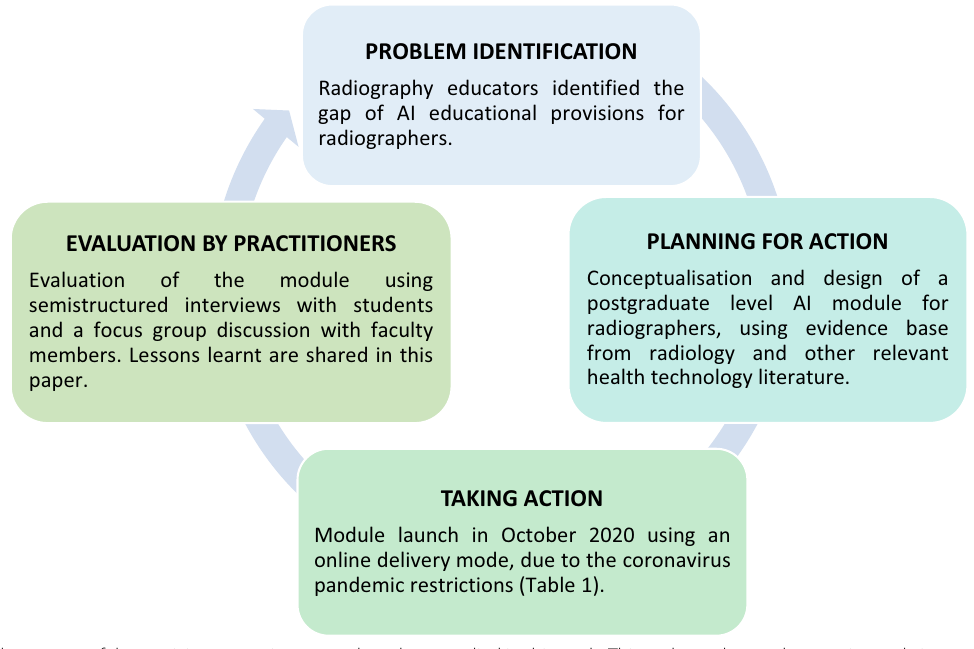
Fig. 1 Visual summary of the participatory action research cycle, as applied in this study. This cycle can be used to continuously improve the module over time, based on student and faculty feedback